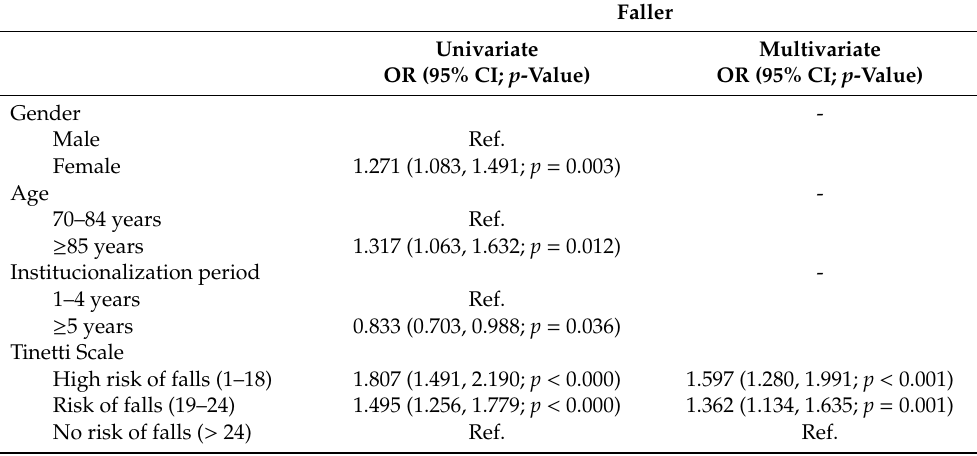
Table 2. Association between sample characteristics and su ff ering at least a fall in the last 12